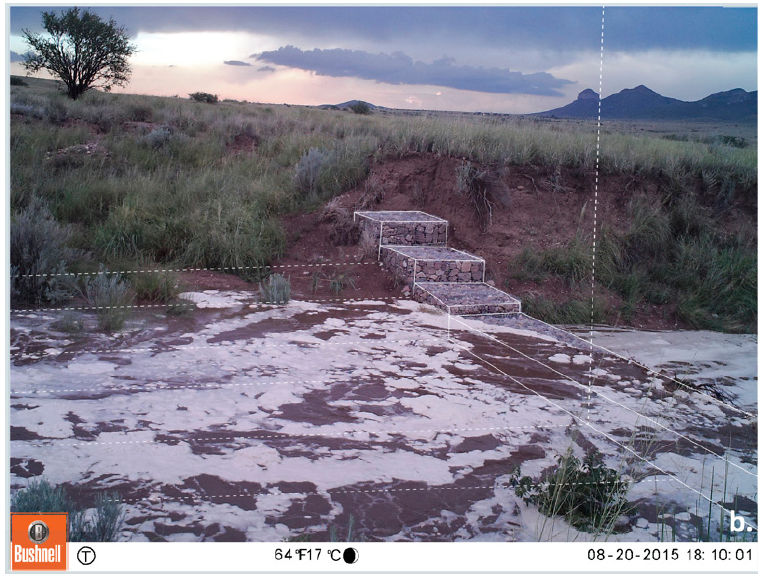
Figure 6. Photo taken 5 min after flow onset. Guidelines were superimposed later to assist in estimating ponding extent by C. Fandel.